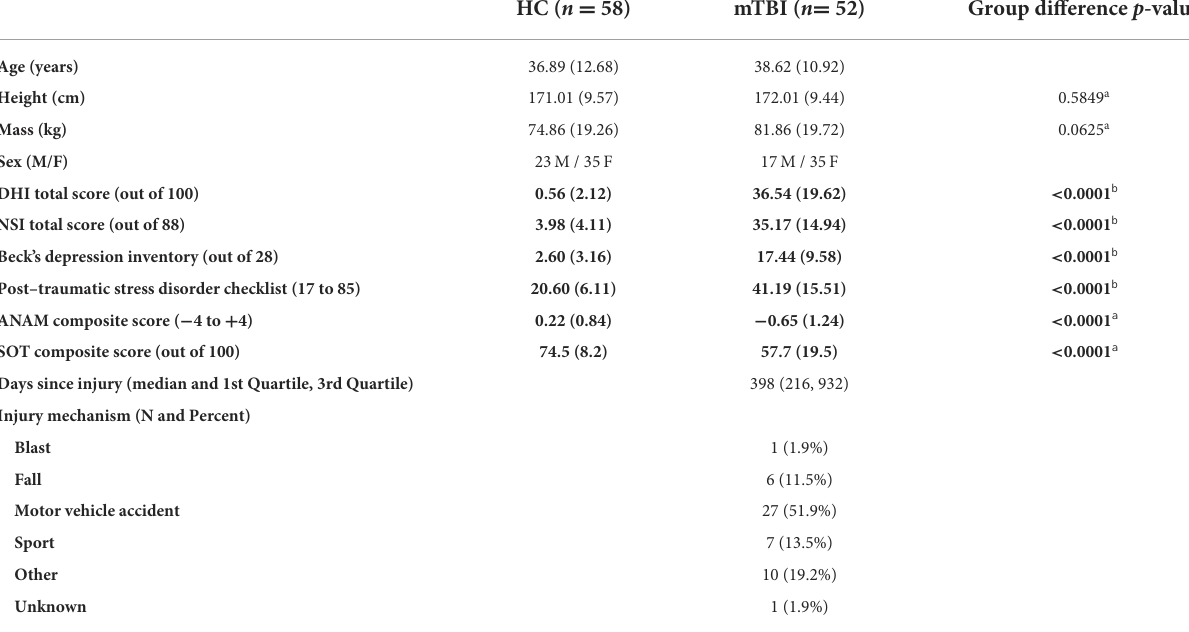
TABLE 1 Participant demographics for the healthy control (HC) group and the chronic mild traumatic brain injury (mTBI)